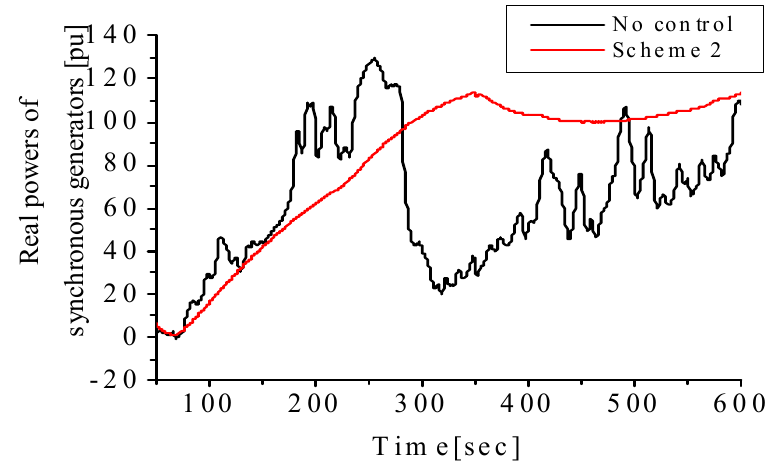
Figure 12. Real powers of steam turbine using Scheme 2.